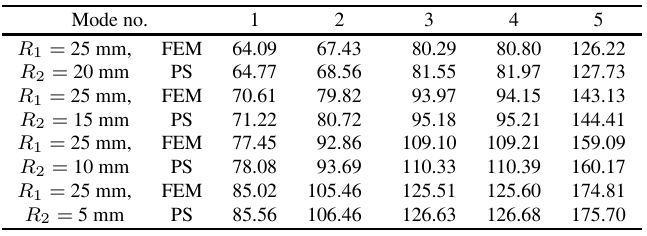
The effect of the ratio ( R 2 /R 1 ) on frequencies ( R 1 = 25 mm, ¯ α = 4.8 ◦ , n =